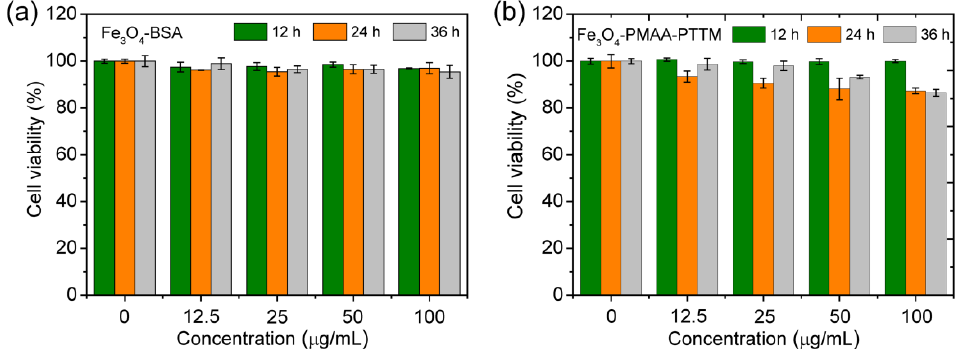
Figure 4. Cell viability of 4T1 cell line after incubation with different concentrations of ( a ) Fe 3 O 4 -BSA and ( b ) Fe 3 O 4 -PMAA-PTTM for 12, 24 and 36 h.